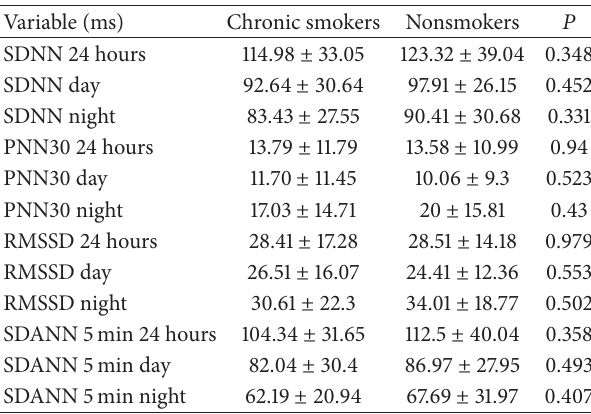
Table 3: Mean values ( ± SD) of time-domain parameters of HRV during 24-hour, day, and night periods.